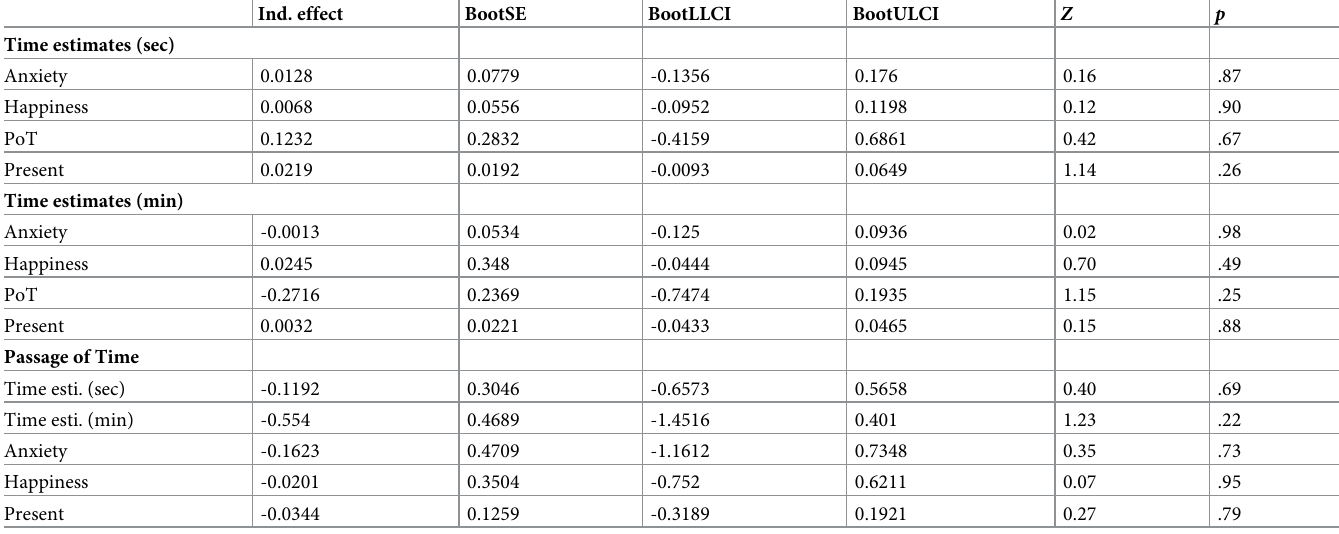
Table 3. Mediating indirect effects on the significant relationship between the mediation exercise and both the time estimates (standardized errors) in the seconds and the minutes range and the passage of time judgment. The bootstrapping mediating method developed by Hayes [46] was used with 95% confident intervals. Coeffi- cients were considered significant when 95% CI did not cross zero (n = 60, 5000